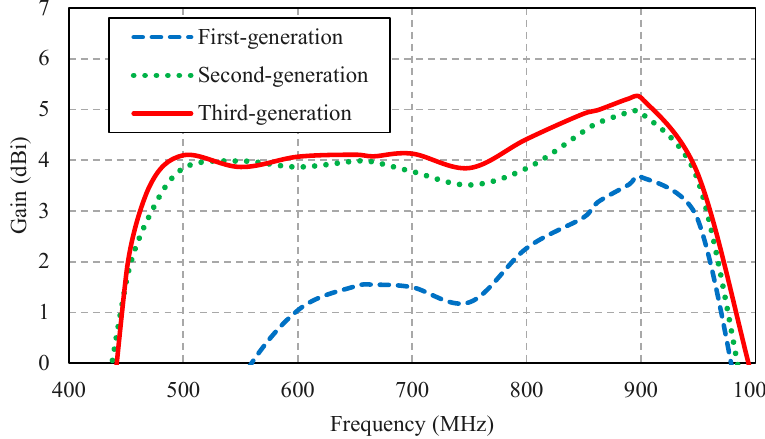
Figure 9. Simulated antenna gains of the first-, second-, and third-generation antenna schemes.